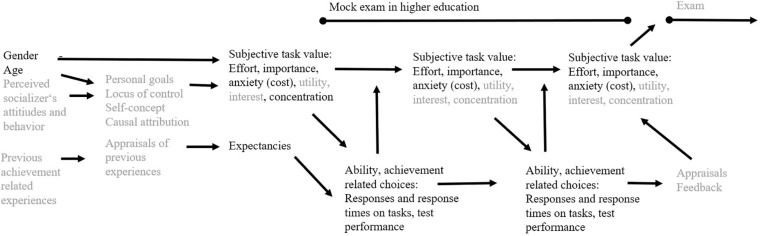
Theoretical model adapted to the mock exam situation in higher education based on previous expectancy-value models (Wigfield and Eccles, 2000; Knekta and Eklöf, 2015). Only constructs written in black font were included in the current study. This study focused on possible decreases of test-taking effort and importance moderated by test battery order with consideration of expectancies, anxiety, and concentration as covariates.